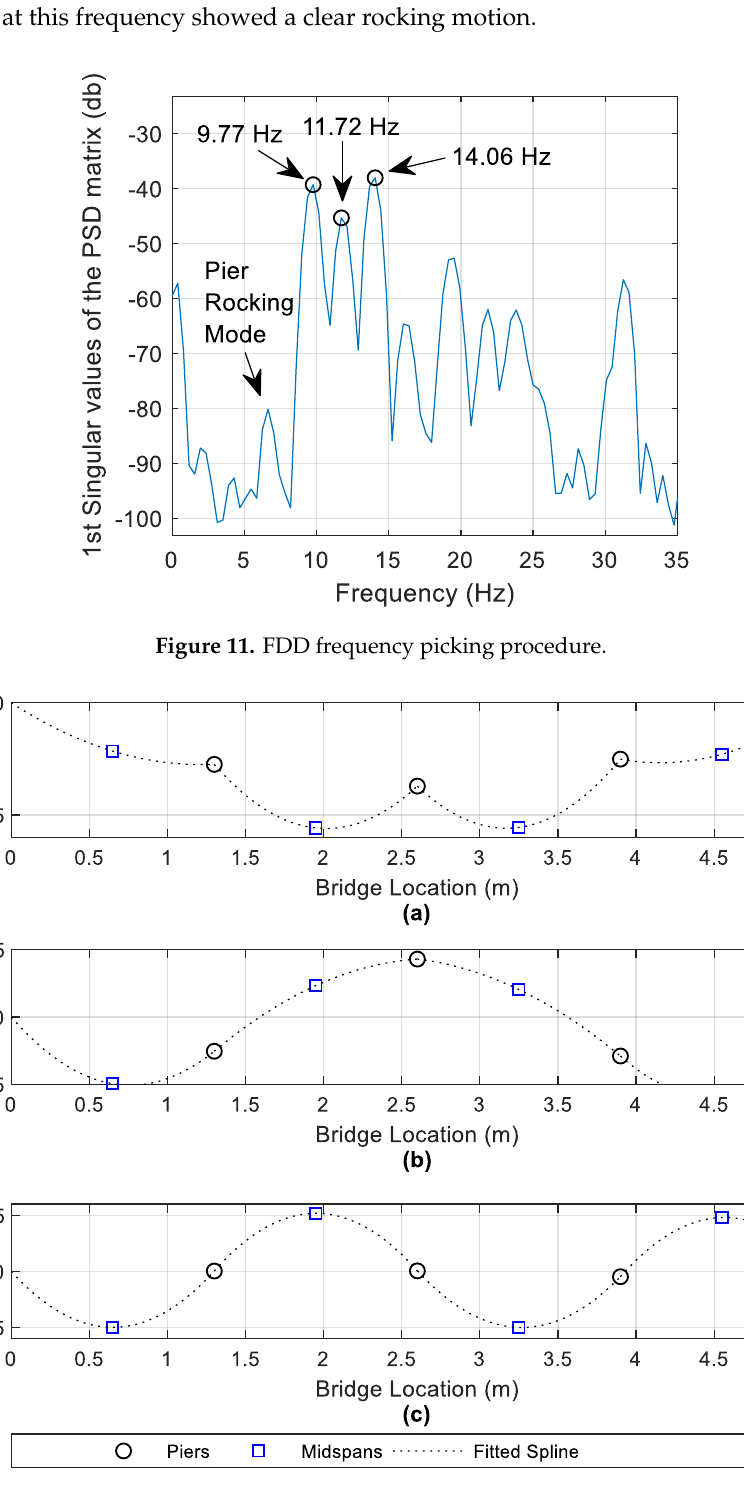
Figure 12. Mode shapes obtained from FDD algorithm—( a ) 9.77 Hz mode, ( b ) 11.72 Hz mode and ( c ) 14.06 Hz mode.